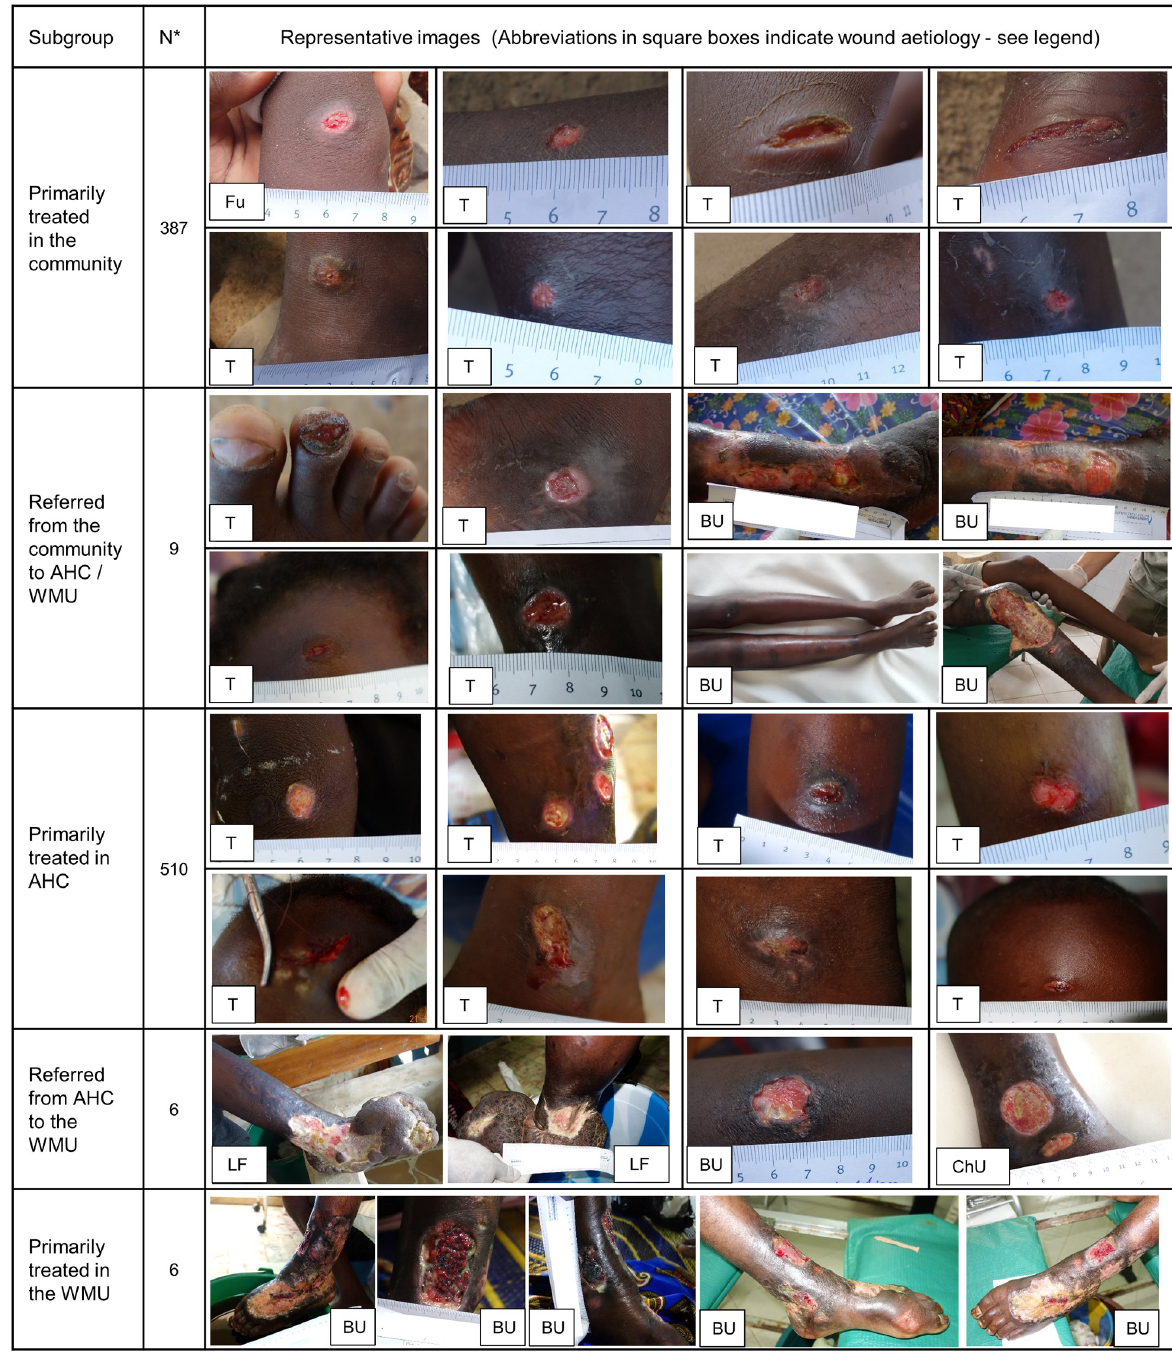
Fig 3. Representative images of the wounds treated within the study stratified by health service level. In the large subgroups “Primarily treated in the community” (N = 387) and “Primarily treated in AHC” (N = 510) the images were randomly selected to rule out selection bias. Multiple pictures are shown for patients with complicated wounds. Abbreviations in the square boxes indicate the wound aetiology: Fu = furuncle (ulcerated), T = Mechanical trauma, BU = Buruli Ulcer, LF = Late-stage lymphatic filariasis, ChU = Chronic wound of unknown origin. AHC: Ahondo Health Centre; WMU: Wound Management Unit. � = Number of wounds.